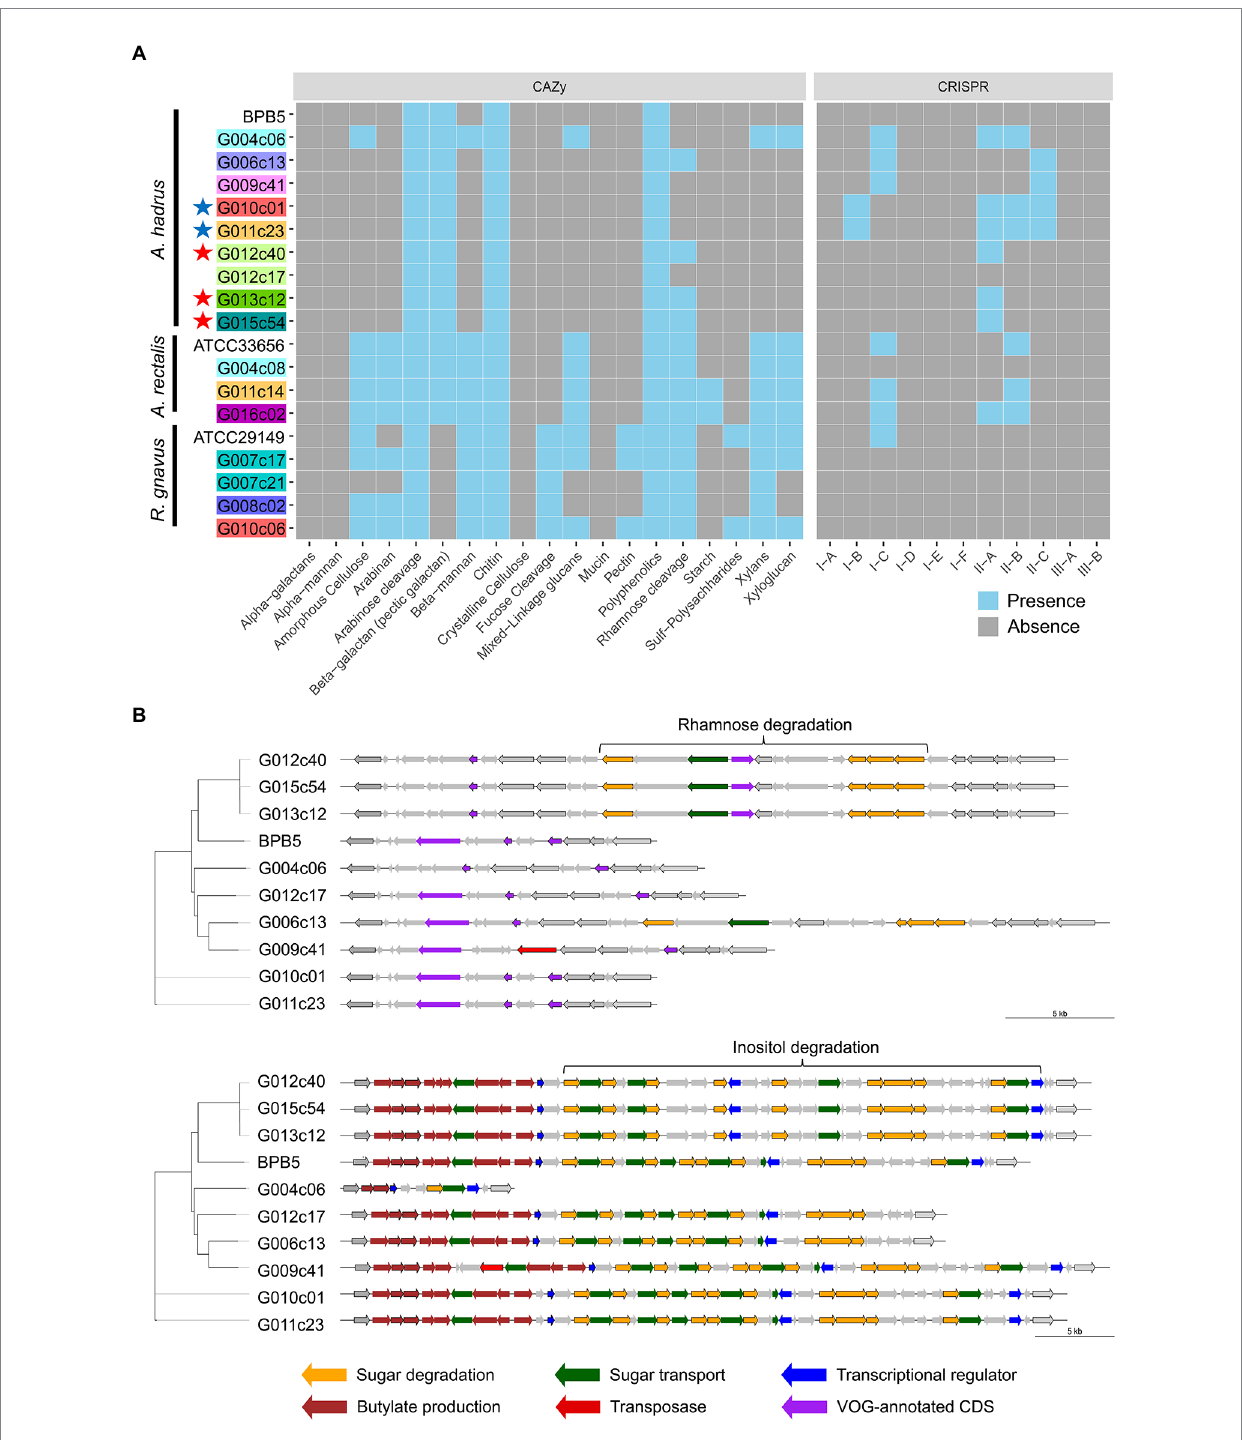
FIGURE 4 Metabolic analysis of gut bacterial circular single-amplified genomes (cSAGs). (A) Heatmap showing various carbohydrate-active enzymes (CAZy) or CRISPR-Cas systems in the genome of each strain. Highlighted labels indicate the host, and colored stars indicate closely related genomes obtained from the cohabitants. (B) Structural variation of polysaccharide metabolic pathways in A. hadrus genomes. Gene clusters in the same regions are aligned. The left phylogram was inferred from the present pattern of orthogroups in whole